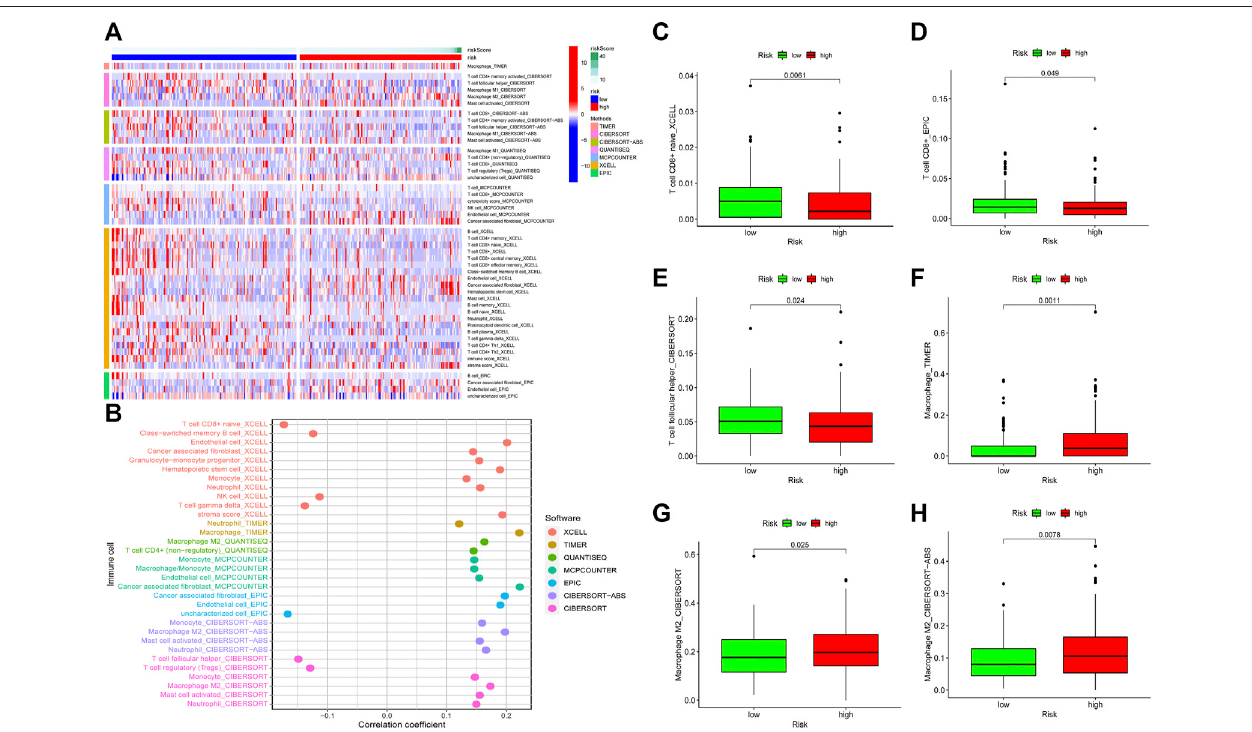
FIGURE 7 | Relationship between the risk model and tumor immune in fi ltration. The in fi ltration status of immune cells between the low-risk patients and the high- riskpatients (A,B) .Differencesinthein fi ltrationofTcellCD8 + cells,Tcellfollicularhelper,macrophage,andM2macrophagebetweenthelow-riskgrouppatientsandthe high-risk group patients were visualized (C – H)